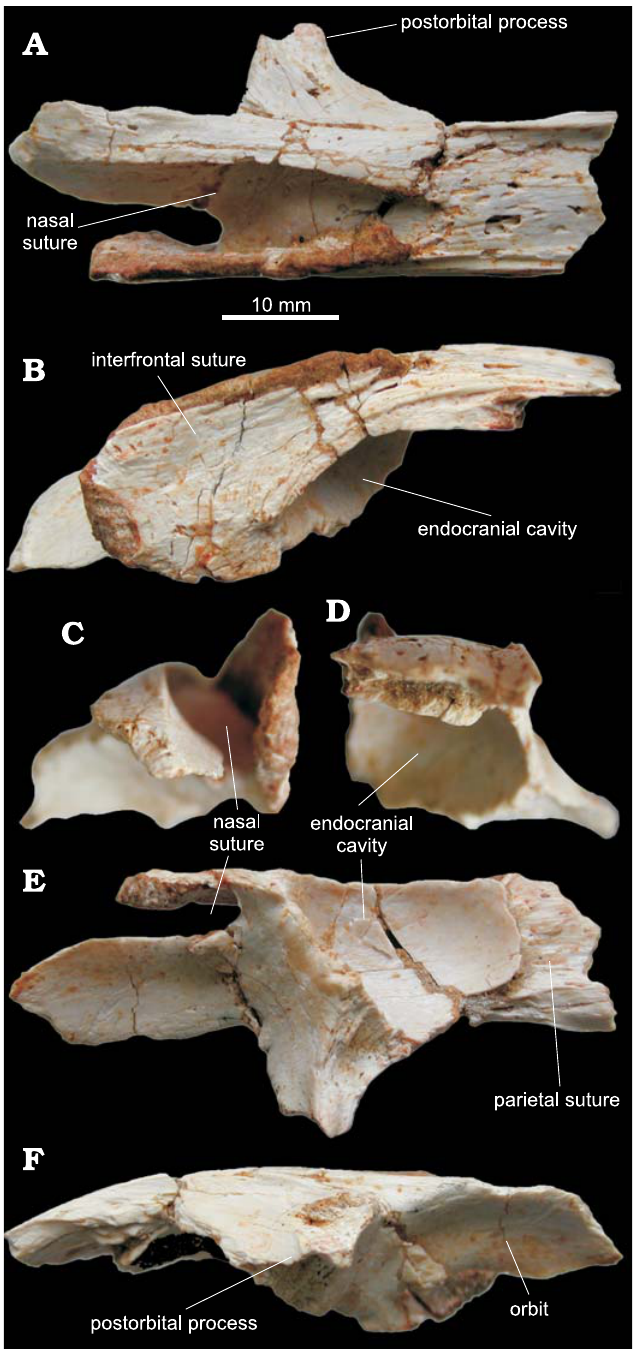
Fig. 1. Crested theropod dinosaur Elmisaurus rarus Osmólska, 1981, MPC-D 102/007 from Nemegt Formation (Upper Cretaceous), Western Sayr of Nemegt locality, Mongolia. Right frontal in dorsal ( A ), medial ( B ), anterior ( C ), posterior ( D ), ventral ( E ), and lateral ( F ) views.